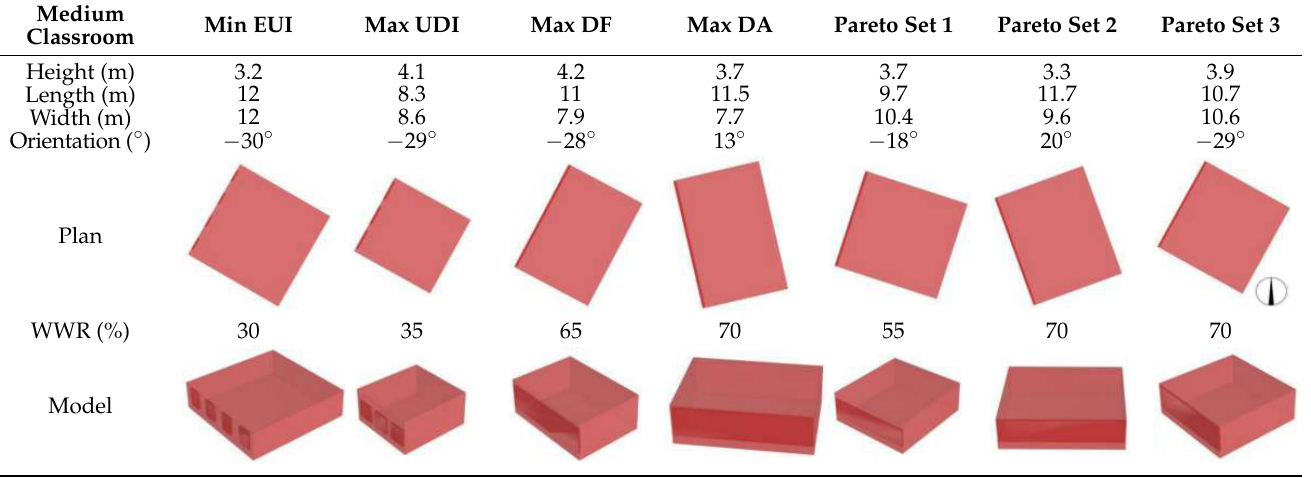
Table 12. Genomes in detail and phenotype outputs for medium-sized classrooms with west fa- cade